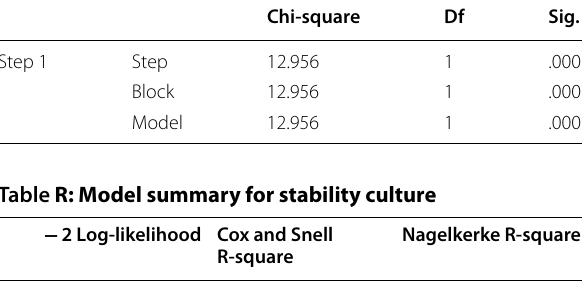
Table J: Model summary for people orientation culture 2 Log-likelihood Cox and Snell − R-square